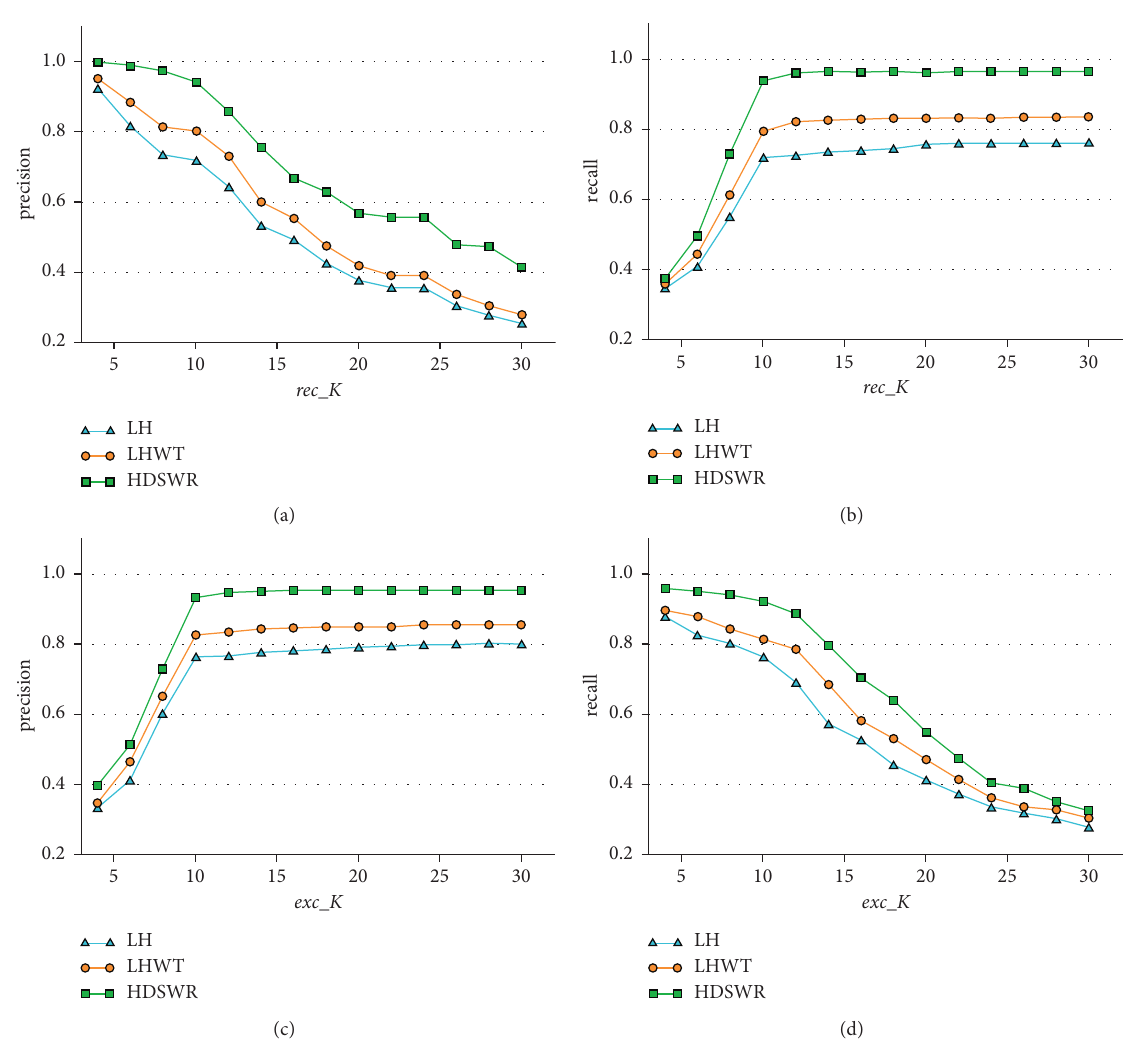
Figure 5: Precision and recall of different recommendation methods on the dataset SW#80.